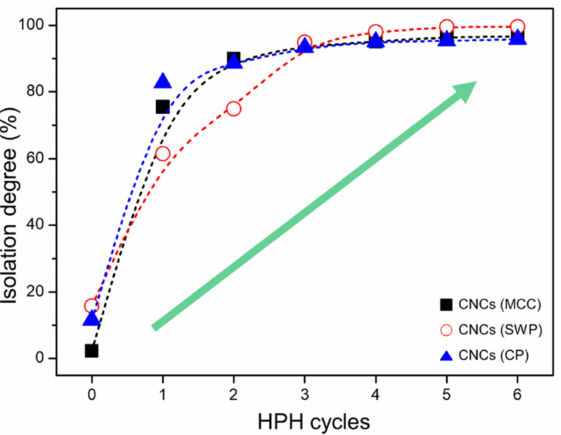
Figure 1. The isolation degree of CNCs suspensions from various cellulose materials following mechanical treatment. Square: CNCs (MCC); circle: CNCs (SWP); triangle: CNCs